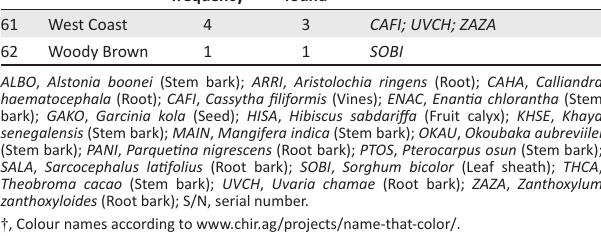
TABLE 2 (Continues...): Distribution of all the colours observed in the powdered medicinal herbs analysed colourimetrically † . S/N Colour name Overall No. of herbs frequency